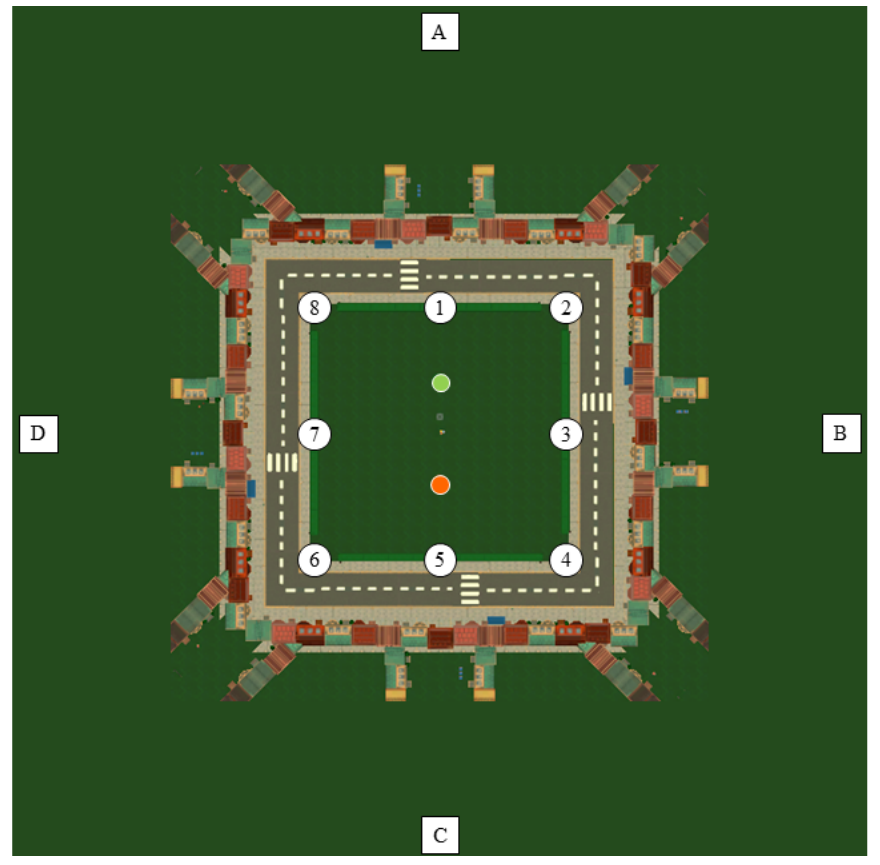
Figure 1. Schematic top view of the virtual environment. White circles with numbers 1–8 represent the possible starting positions (i.e., entrances to the park). The bright green and orange dot in the middle represent two trees with distinctly coloured leaves that served as proximal cues. White squares with letters ( A – D ) represent four distinct large buildings that served as distal cues. Note that the distance of the distal cues to the park has been scaled down, and that streets further away from the park have been left out of the image, for illustrative purposes.